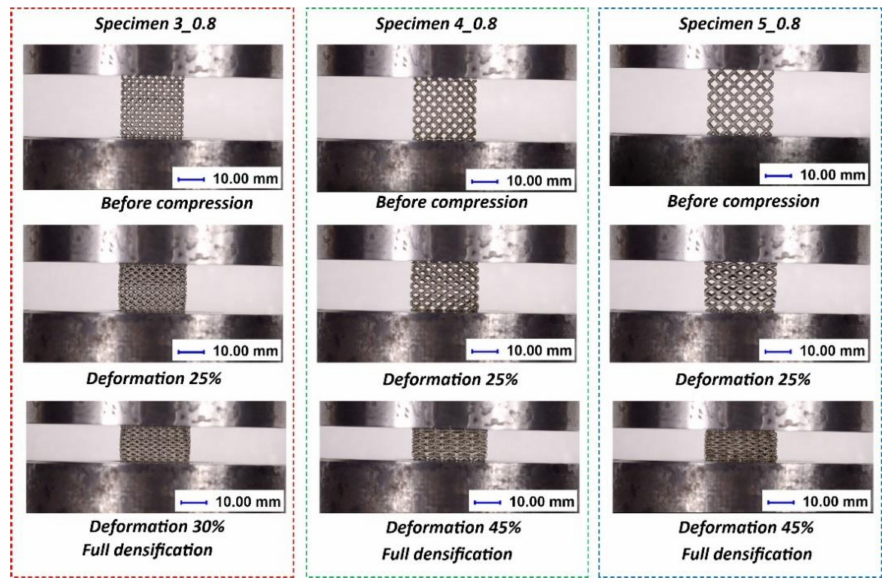
Figure 17. Exemplary views of the specimen deformation